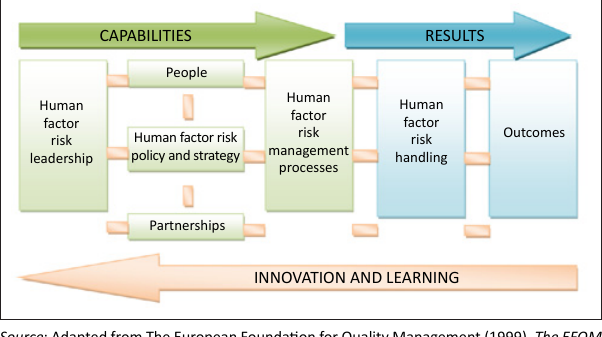
FIGURE 3: Human Factor Management Assessment Risk